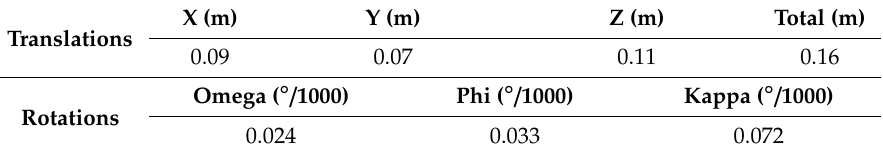
Table 1. Mean standard deviations of translations and rotations.